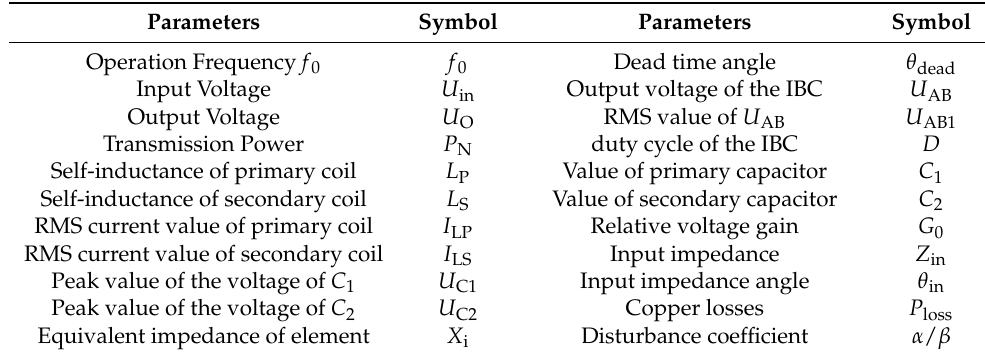
Table 1. Main electrical and physical parameters of the prototype.